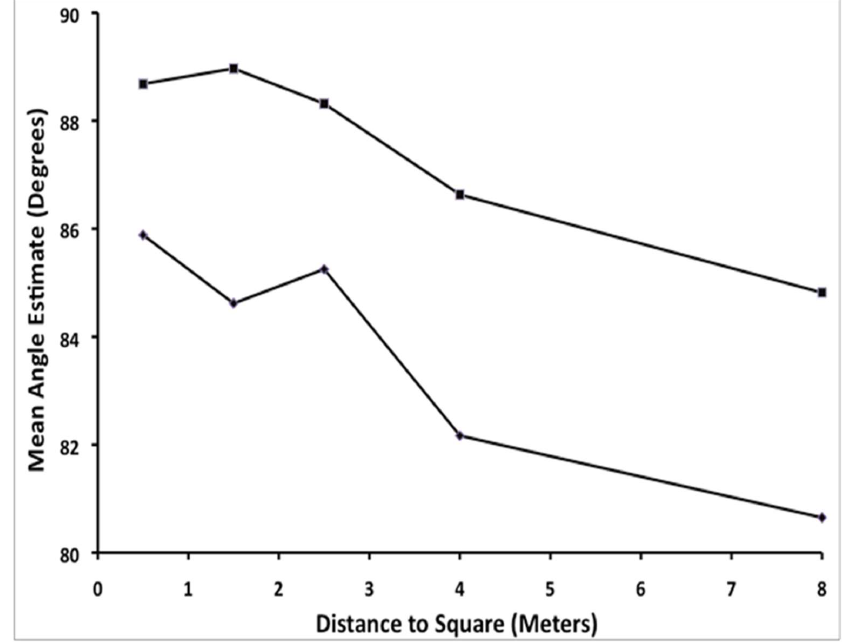
Figure 2. Mean angle estimate (in degrees) as a function of distance from the observer to each square (in meters) and location of angle within a square for Experiment 1. Diamonds (bottom line) indicate mean angle estimates for near angles and squares (top line) indicate mean angle estimates for far angles within a square.